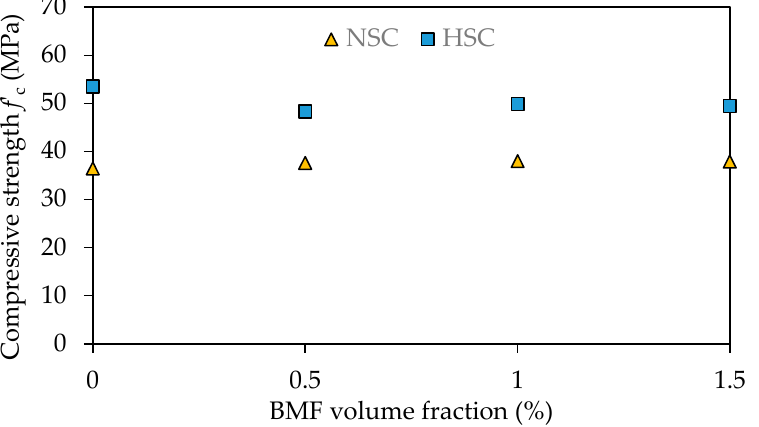
Figure 9. Cylinder compressive strength ( f’ c ) of NSC and HSC. Table 7. Mechanical properties of concrete mixtures.